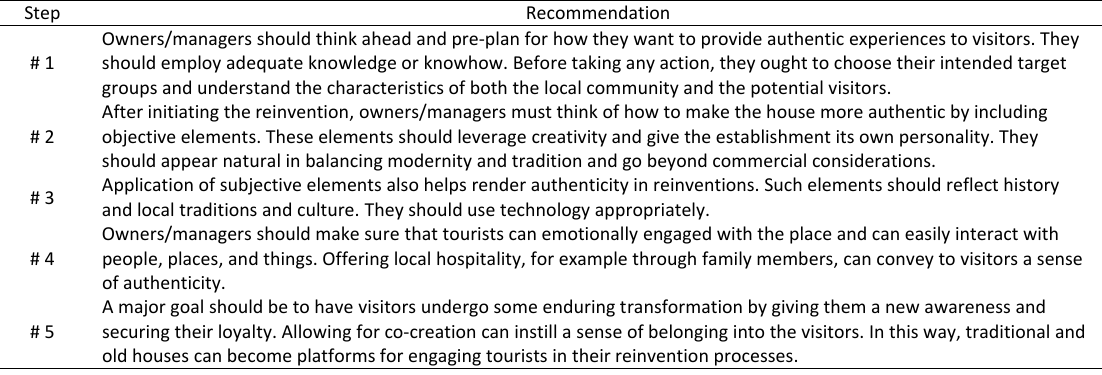
Table 3: Recommendations for owners/operators of reinvented houses/ecolodges